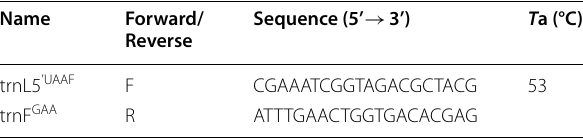
Table 3 Description and amplification conditions of cpDNA primer pair used for the molecular study